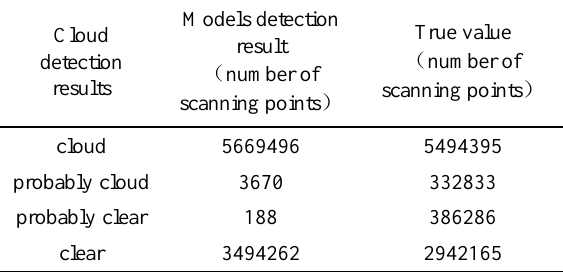
Table 6. Model cloud test results and true values on training dataset